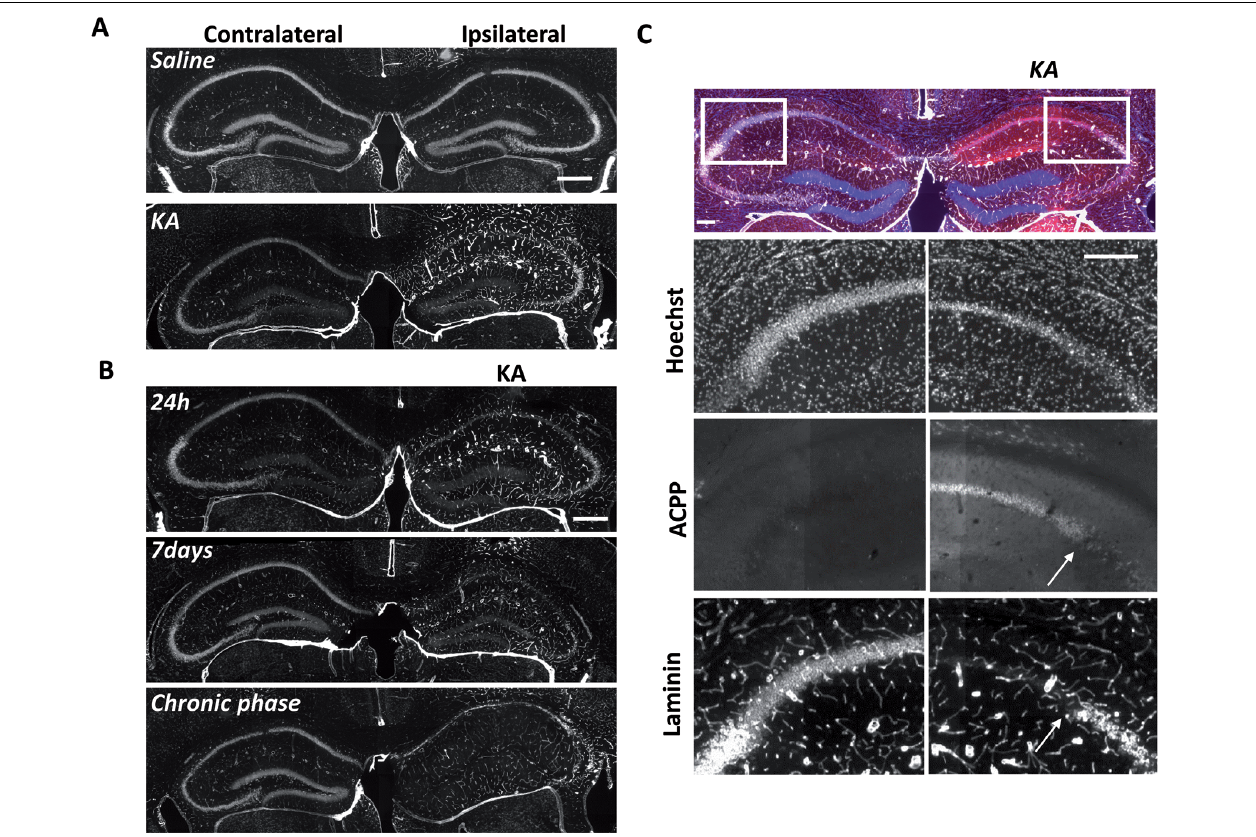
FIGURE 5 | Uptake of ACPP is superimposed to loss of neuronal laminin in KA treated brain. (A) Laminin immunoreactivity in saline or KA-injected hippocampus 24 h after injection. (B) Progressive changes of laminin expression during the different phases of epileptogenesis. (C) Magnification of laminin loss in CA1–CA2 region 7 days after KA injection. The white arrow shows the limit between ACPP uptake and intact laminin (right panels), whereas no TAMRA fluorescence is detectable in the contralateral side and laminin is intact. TAMRA ACPPs (red), Laminin (white), Hoechst (blue). Scale bars: (A , B) 500 µ m, (C) 200 µ